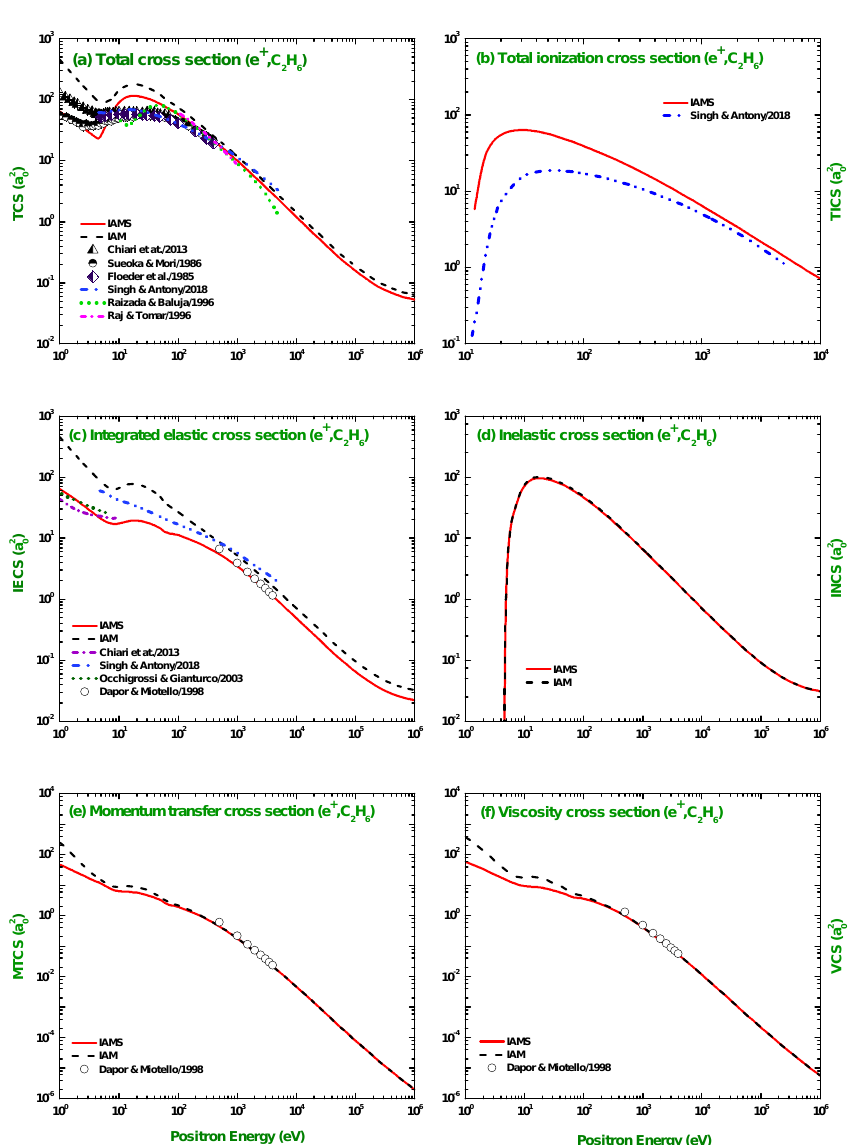
) for the scattering of 0